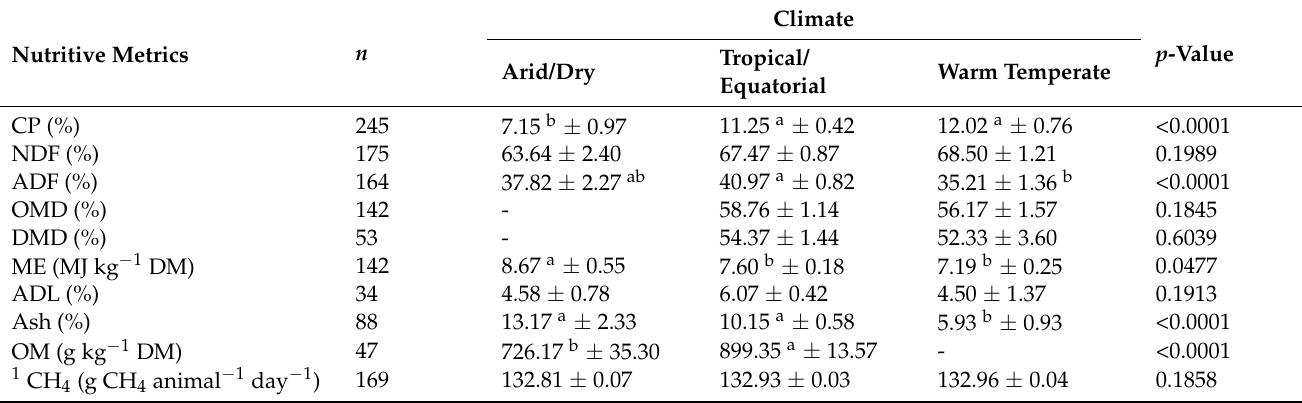
Table 2. Least squares means ( ± SE) of nutritive values within bioclimatic zones described by the Köppen-Geiger climate classification